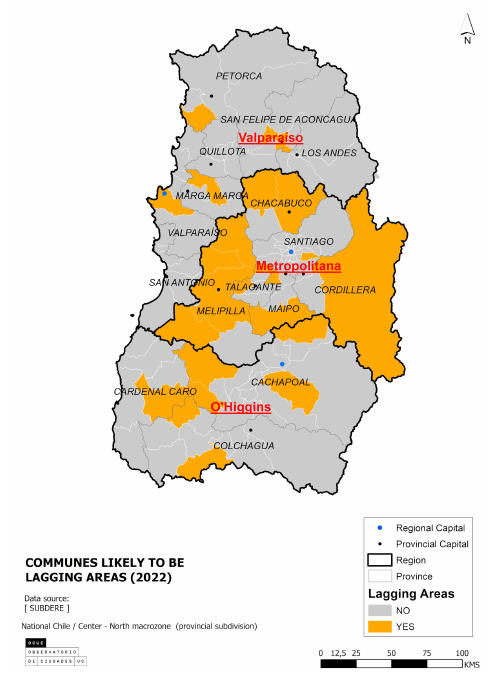
Figure 7: Lag zones by district and province of the central-north macrozone of Chile